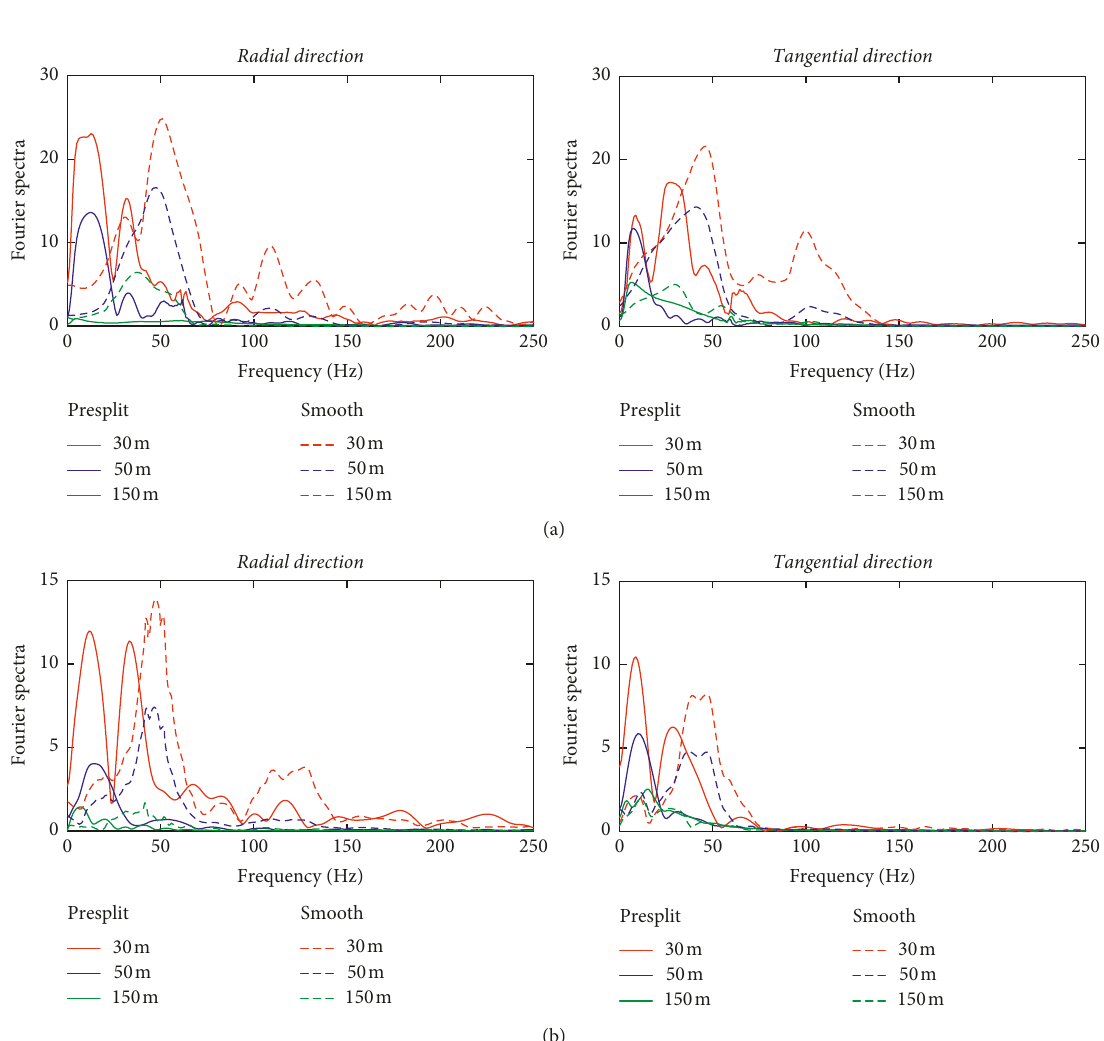
Figure 6: The frequency spectra of vibration signals from (a) main and (b) peripheral boreholes in the radial and tangential directions based on presplit and smooth